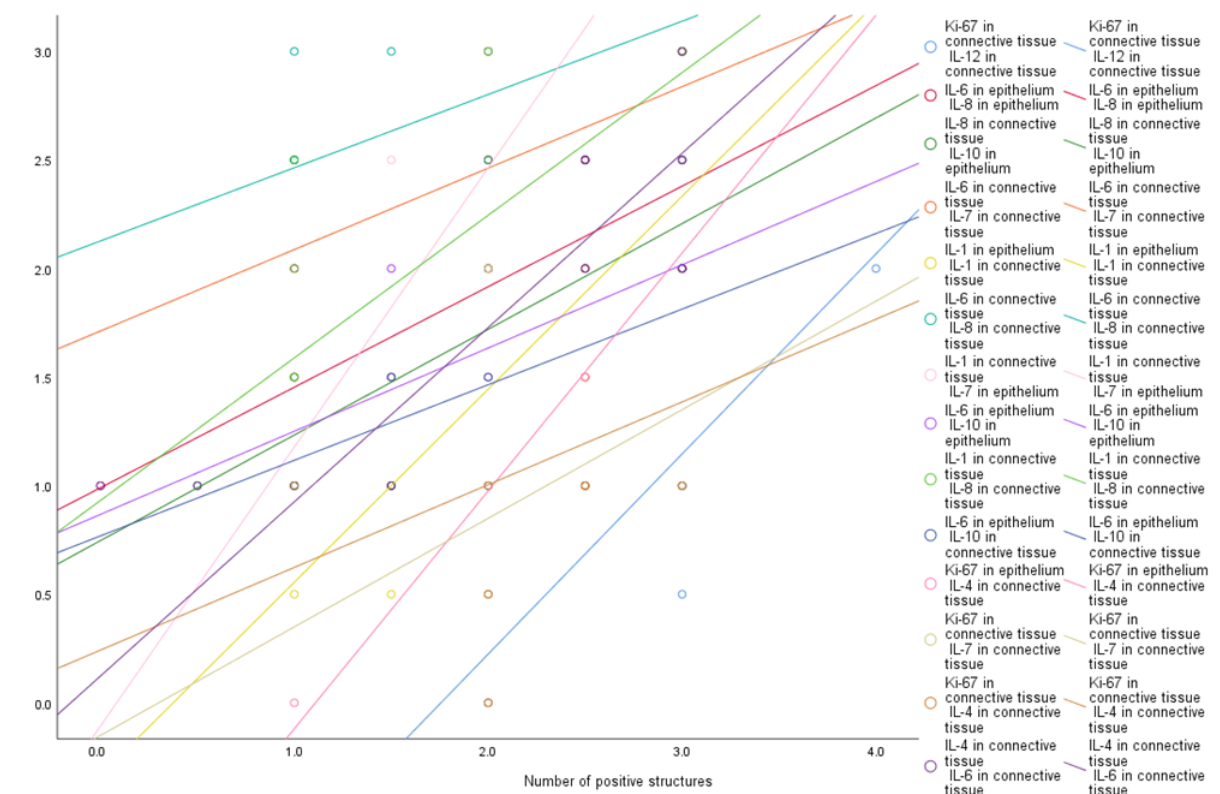
Figure 7. Strong correlations among cytokines and proliferation marker Ki 67. Abbreviations: Ki 67 — proliferation marker; IL- 1α — interleukin 1 alpha; IL-4 — interleukin 4; IL-6 — interleukin 6; IL-7 — interleukin 7; IL-8 — interleukin 8; IL-10 — in- terleukin 10; IL-12 — interleukin 12.